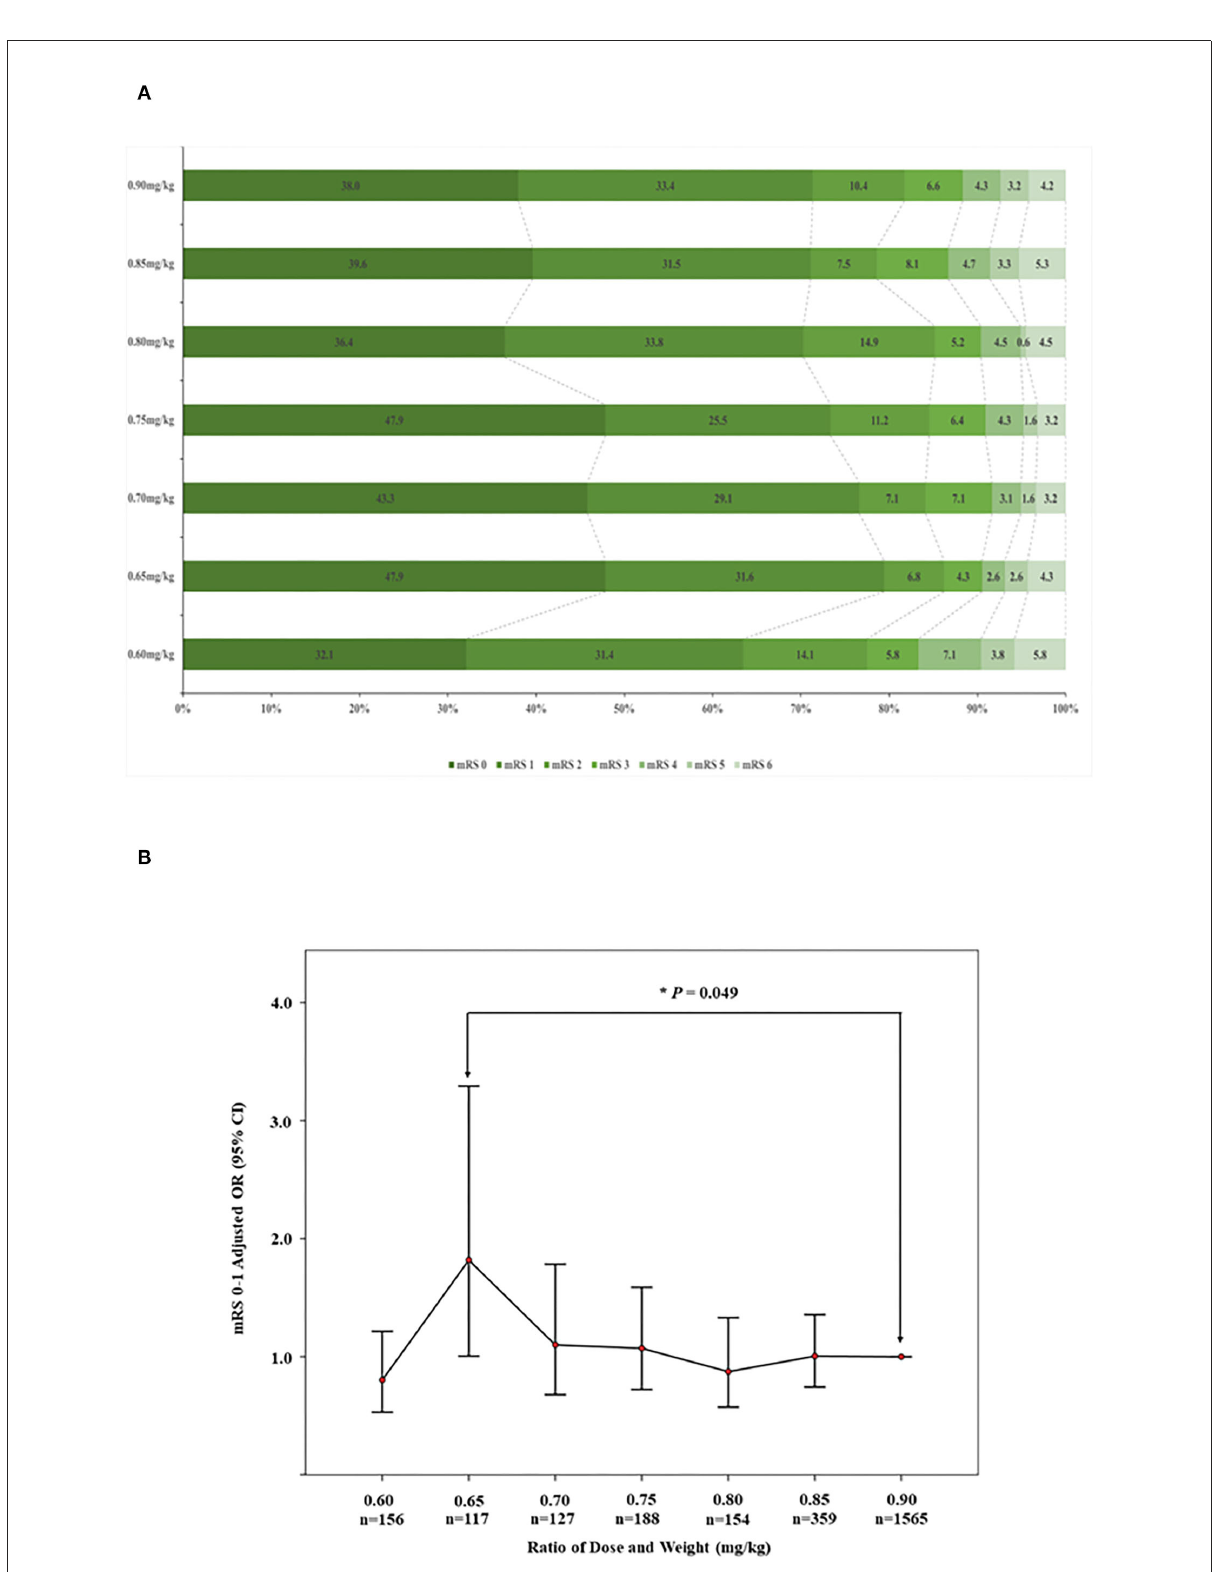
FIGURE2 (A) Comparison of mRS scores at 90 days by the dose of r-tPA. mRS, modified Rankin scale. (B) Adjusted comparing in proportion of 90-day modified Rankin Scale scores 0–1 in 0.65 vs. 0.9 mg/kg groups. OR, odds ratio; CI, confidence